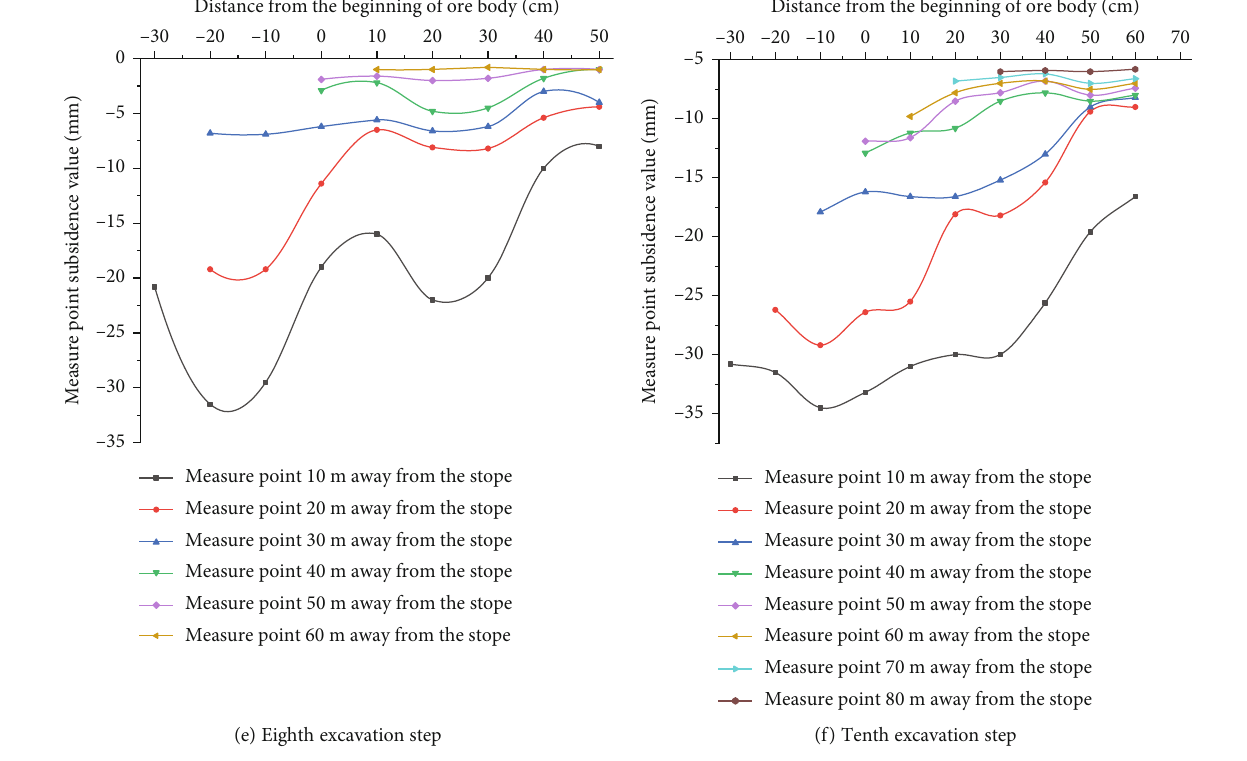
Figure 4: Subsidence displacements after each excavation step of the similar material model.